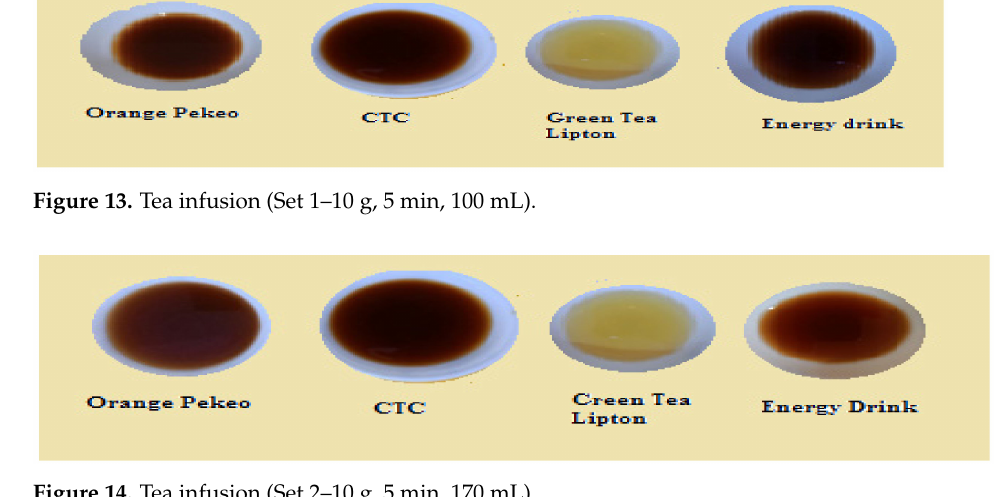
Figure 14. Tea infusion (Set 2–10 g, 5 min, 170